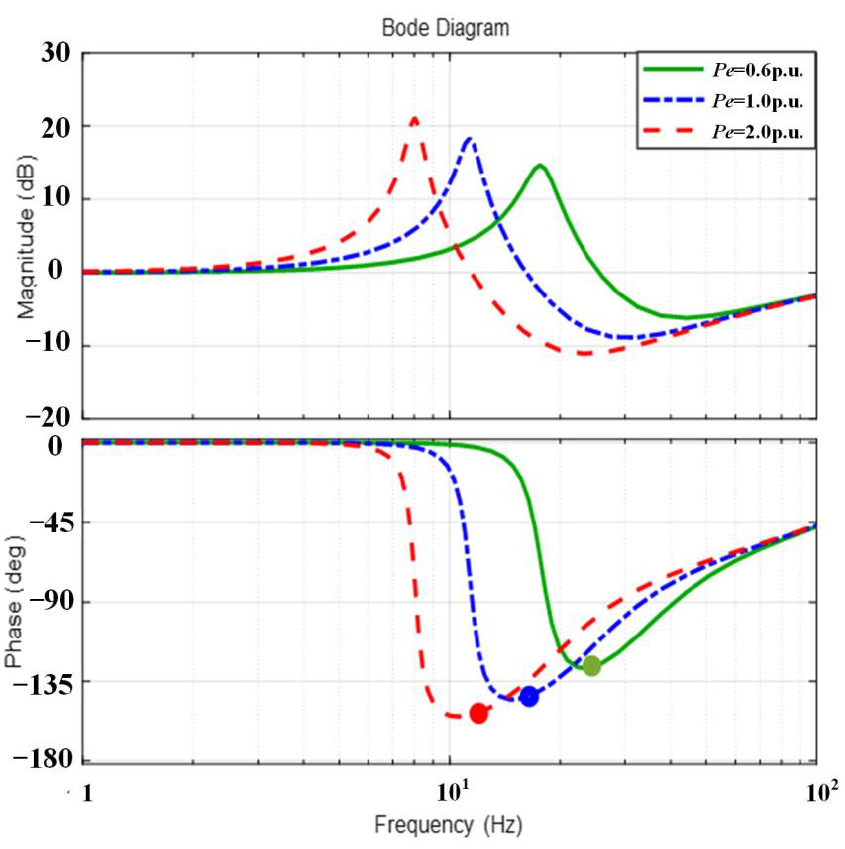
Figure 12. Bode diagram of G 2 ( s ) for different operating points.